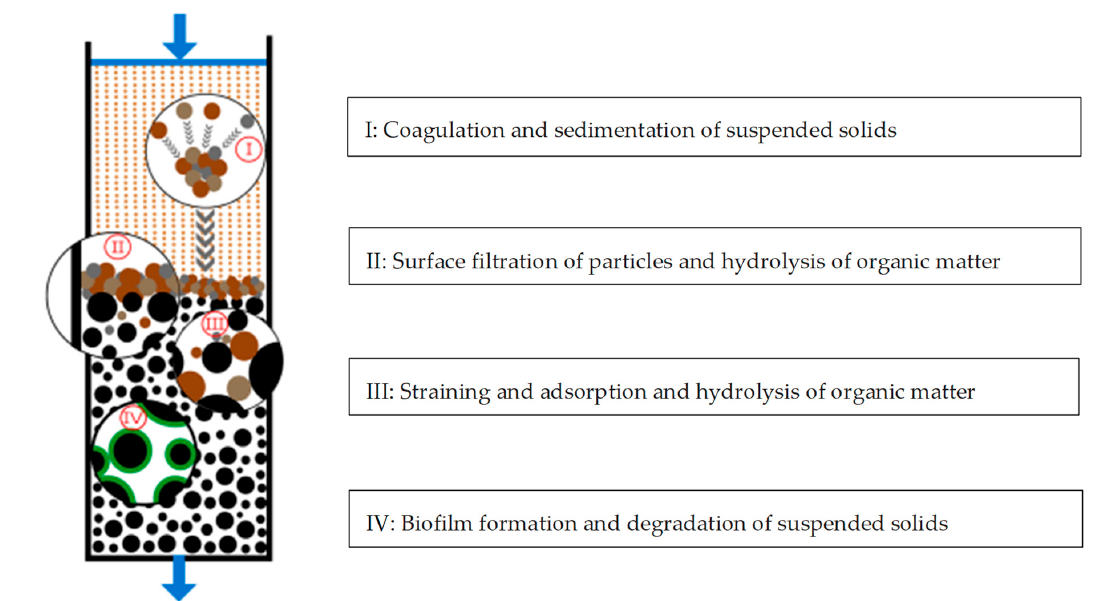
Figure 3. Estimated removal mechanism in an anaerobic biofilter using rice husk biochar as biofilter material. Reproduced from reference [186], copyright (2019), with permission from Elsevier B.V.